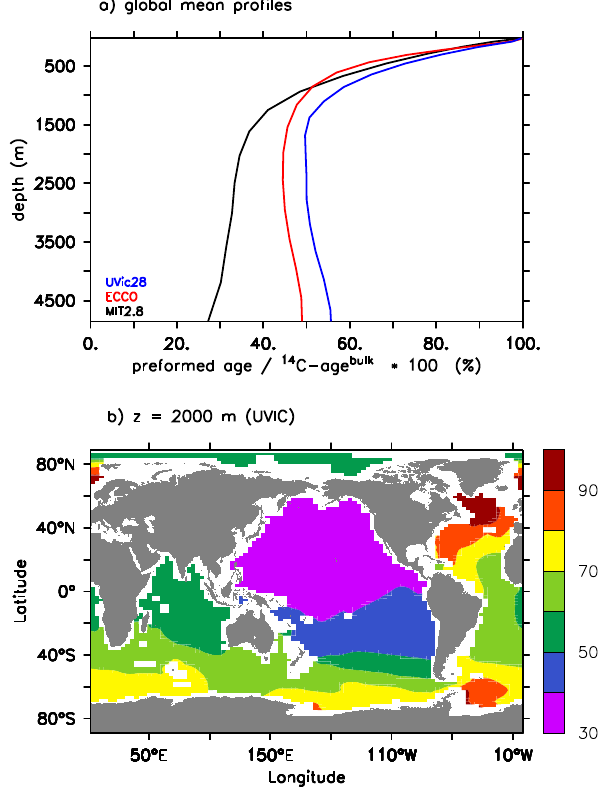
Figure 9. (a) Global mean profiles of the relative contribution (%) of preformed age (estimated as bulk 14 C-age − ideal age) to the bulk 14 C-age. (b) As Fig. 9a, but for the UVIC model in 2000m depths, displaying that even in the oldest waters of the North Pacific the preformed age is a significant component of the bulk